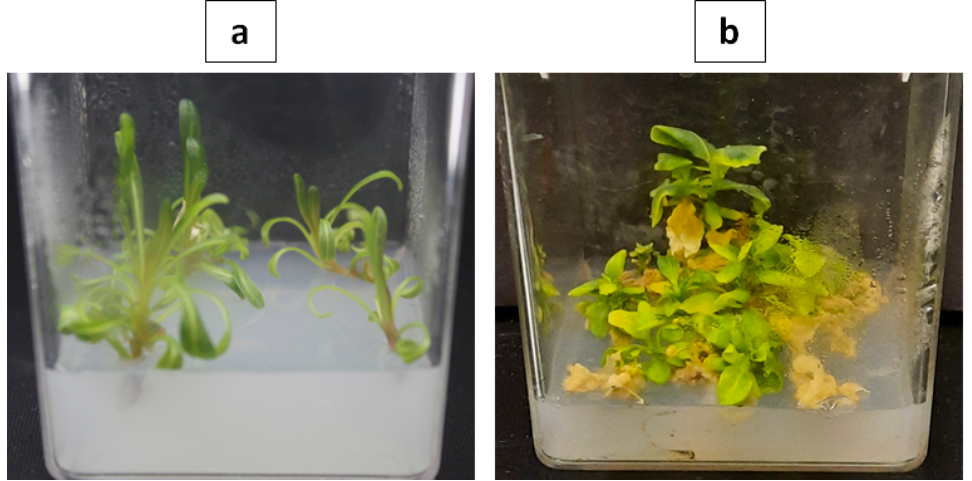
Figure 1. Shoots raised on MS medium ( a ) Reseda lutea ; ( b ) Reseda pentagyna.